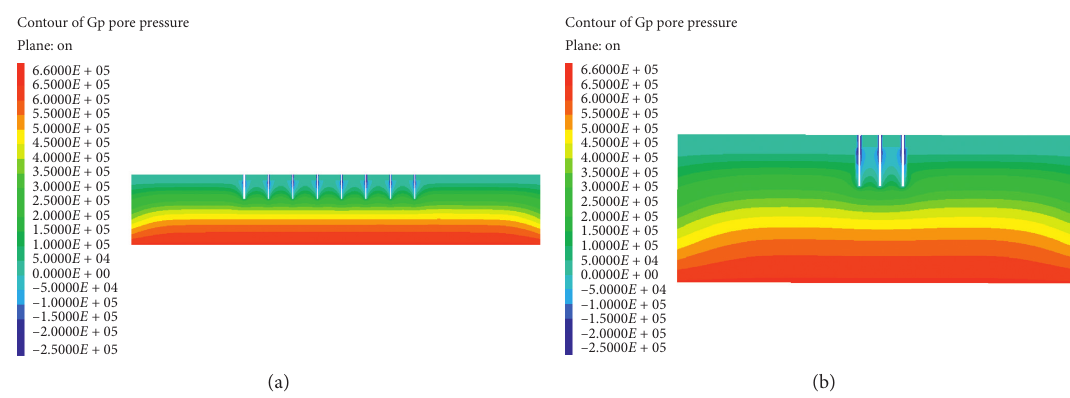
Figure 30: Group wells pore water pressure nephogram after the third drawdown (unit: Pa). (a) Cross section of the well midpoint. (b) Longitudinal section of the well